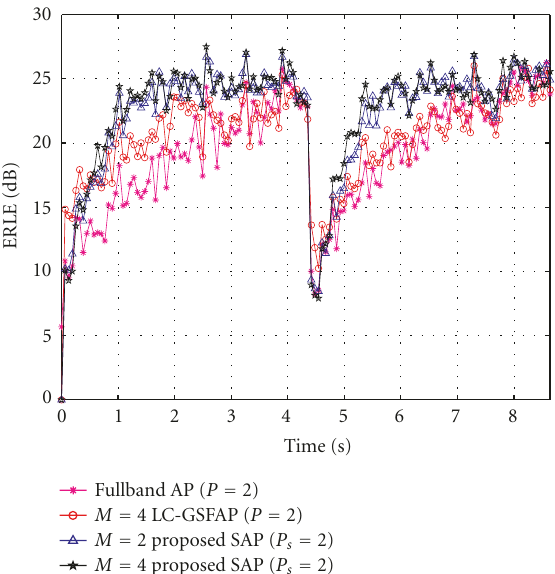
Figure 7: ERLE curves of the fullband AP with P = 2, M = 4 LC- GSFAP with P = 2 and D = 2, M = 2 SAP with P s = 2, and M = 4 SAP with P s = 2 for AR(4) inputs ( N = 512, μ = 1, SNR = 30